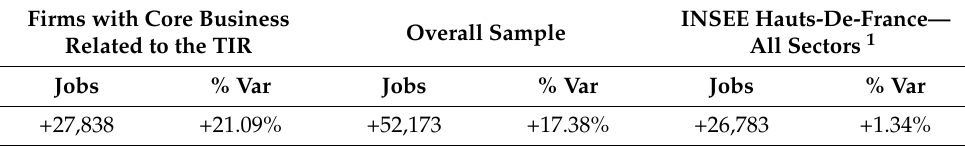
Table 1. Estimation of direct employment growth from 2013 to 2018.